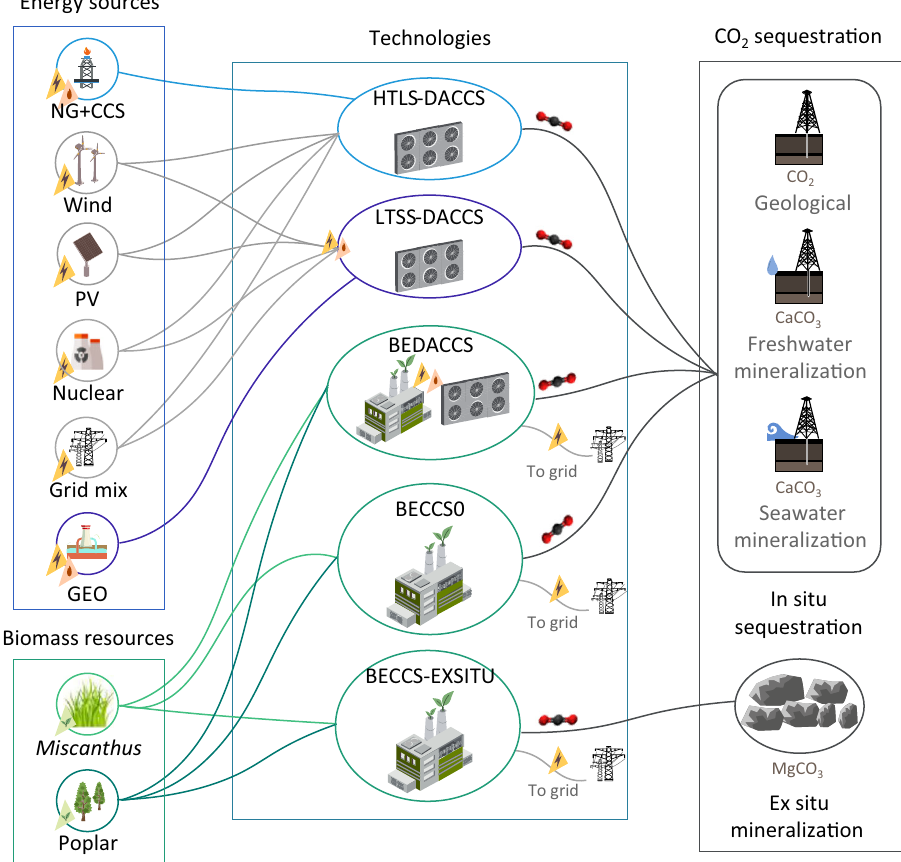
Fig. 1 Overview of the assessed NETs scenarios. High-Temperature Liquid Sorbent (HTLS) and Low-Temperature Solid Sorbent (LTSS) Direct Air Carbon Capture and Storage (DACCS) — powered by natural gas with carbon capture and storage (NG + CCS), wind, solar photovoltaic (PV), nuclear, geothermal (GEO), or the global electricity mix — , the basic Bioenergy with Carbon Capture and storage (BECCS) scenarios (BECCS0) deploying Miscanthus or poplar, the hybrid BEDACCS con fi gurations integrating BECCS0 and LTSS-DACCS, and the BECCS scenarios where CO 2 is mineralized ex situ (BECCS-EXSITU). The CO 2 in situ sequestration options include geological sequestration at high pressure and mineral carbonation with freshwater or seawater. The set of scenarios generating bioenergy include BECCS0, BEDACCS and BECCS-EXSITU, all referred to as